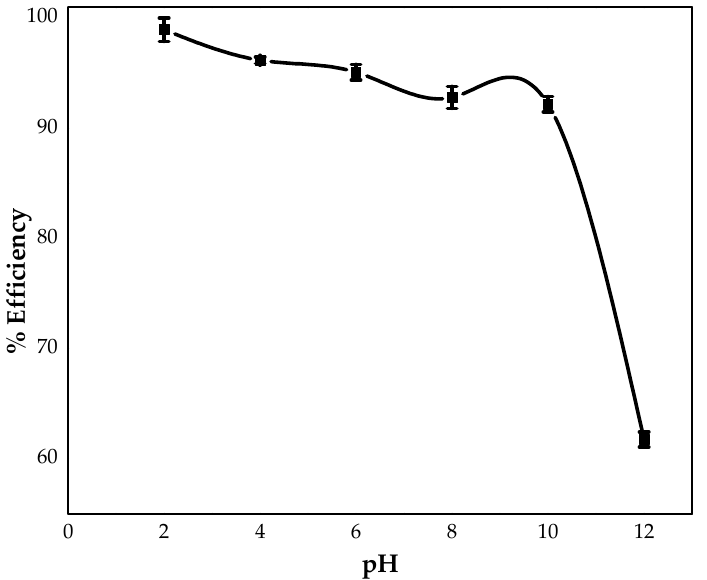
Figure 6. The effect of initial pH of alizarin solution on the extraction efficiency by DES-3 (initial concentration of alizarin = 200 mg/L, contact time = 5 min, DES dosage = 0.15 mL at 25 °C).